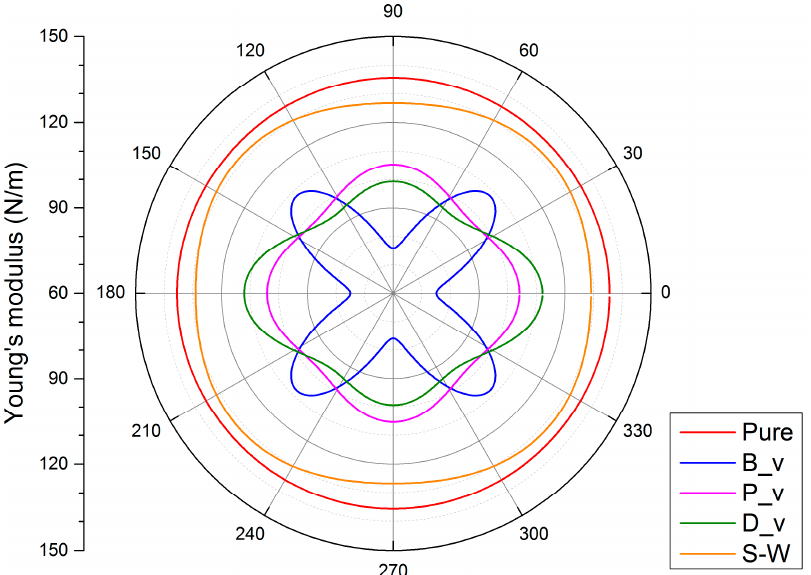
Figure 3. Polar diagrams of the in-plane Young’s modulus for pure and defective boron-phosphide monolayers.